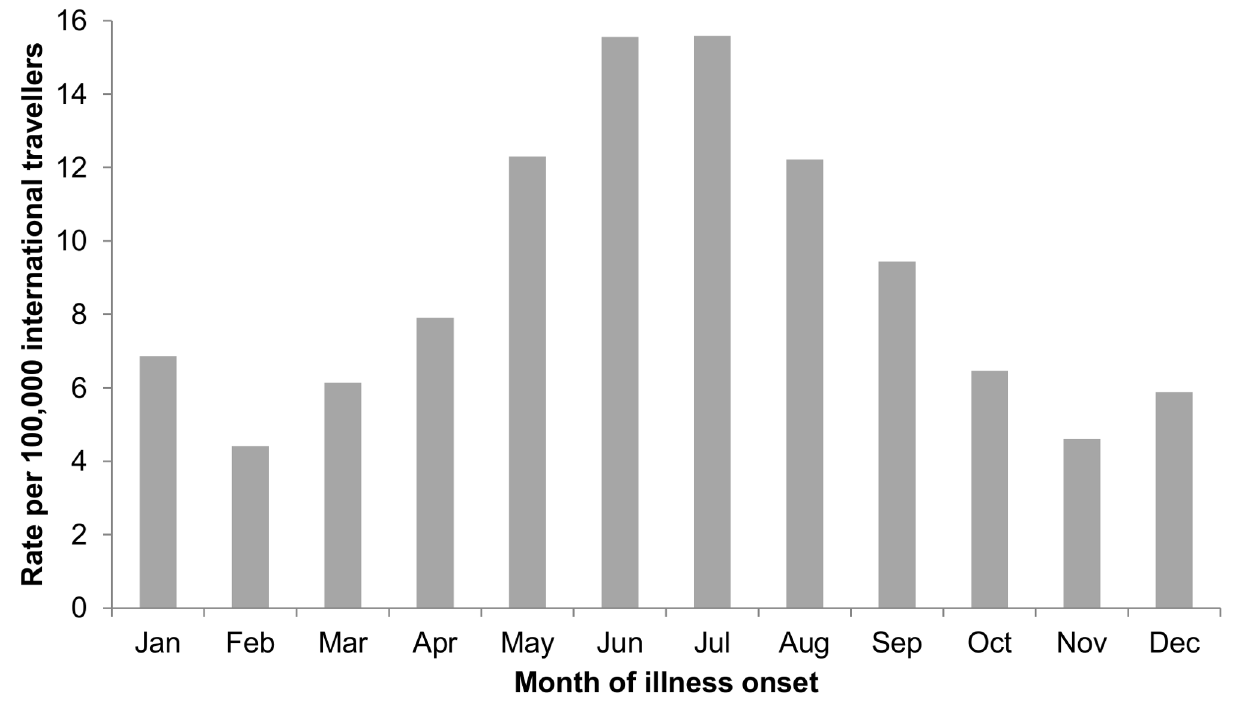
Figure 6. Plasmodium infection rate per month for imported malaria cases (all Plasmodium species) in Ontario, Canada (1990–2009) *. *Rate per 100,000 international travellers estimated based on total Canadians travelling to international locales (except USA) and returning to Ontario [13].